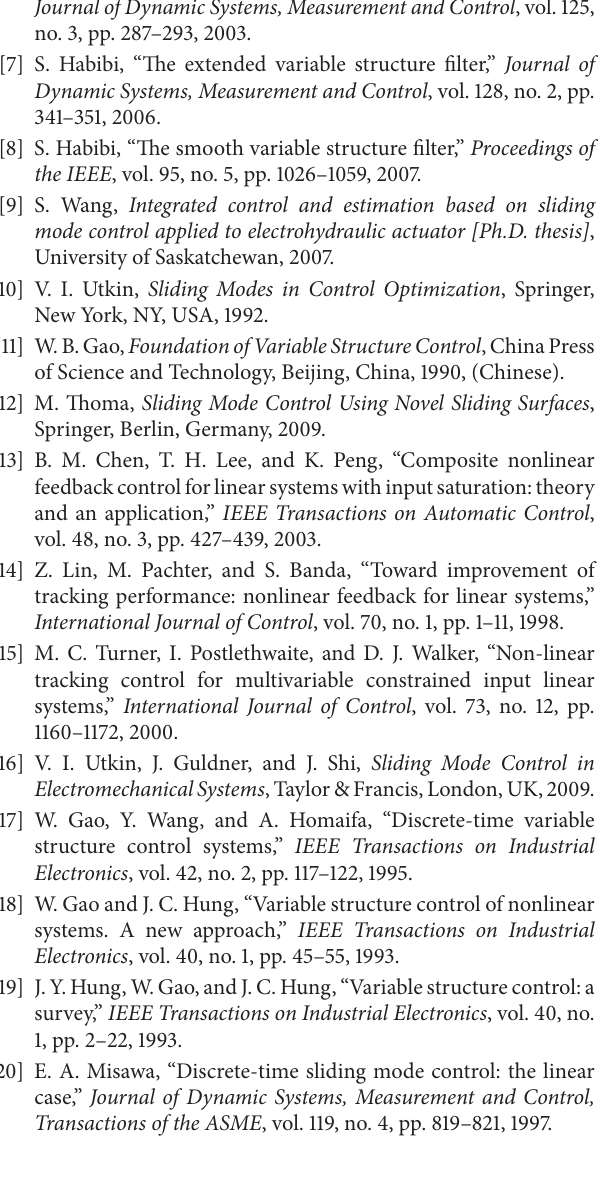
controller with nonlinear surface has lower settling time and faster